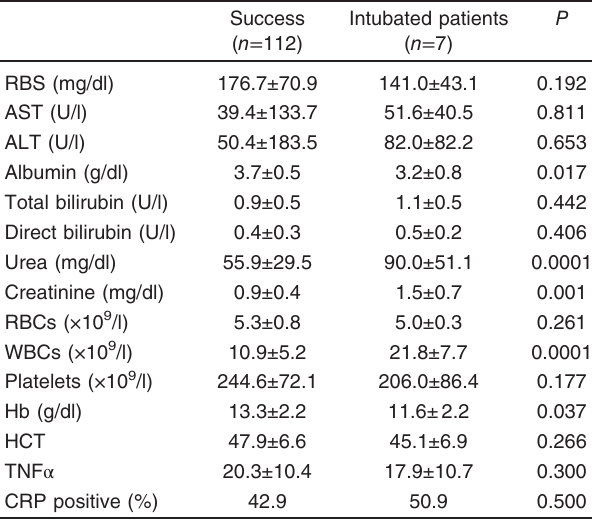
Table 5 Differences between the success and failure groups regarding the laboratory